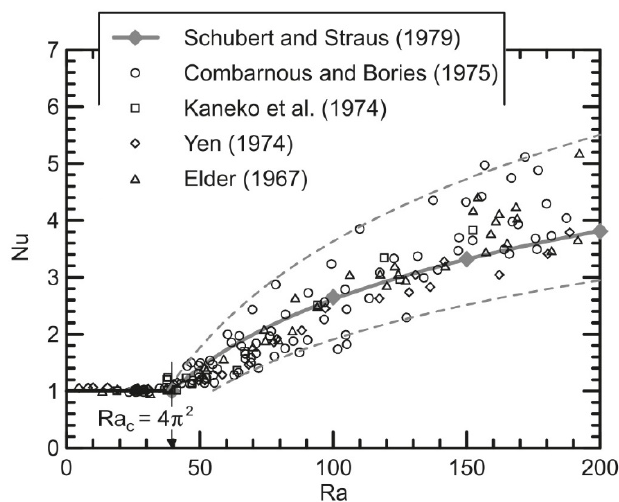
Figure 3. Experimental and analytical Nu–Ra relationships in porous media in a square enclosure heated from below (Côté et al., 2011 [6]).